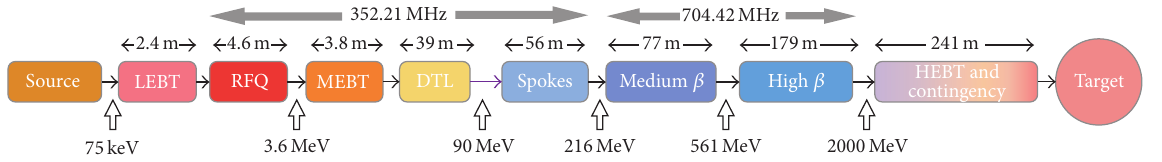
Figure 1: The ESS superconducting